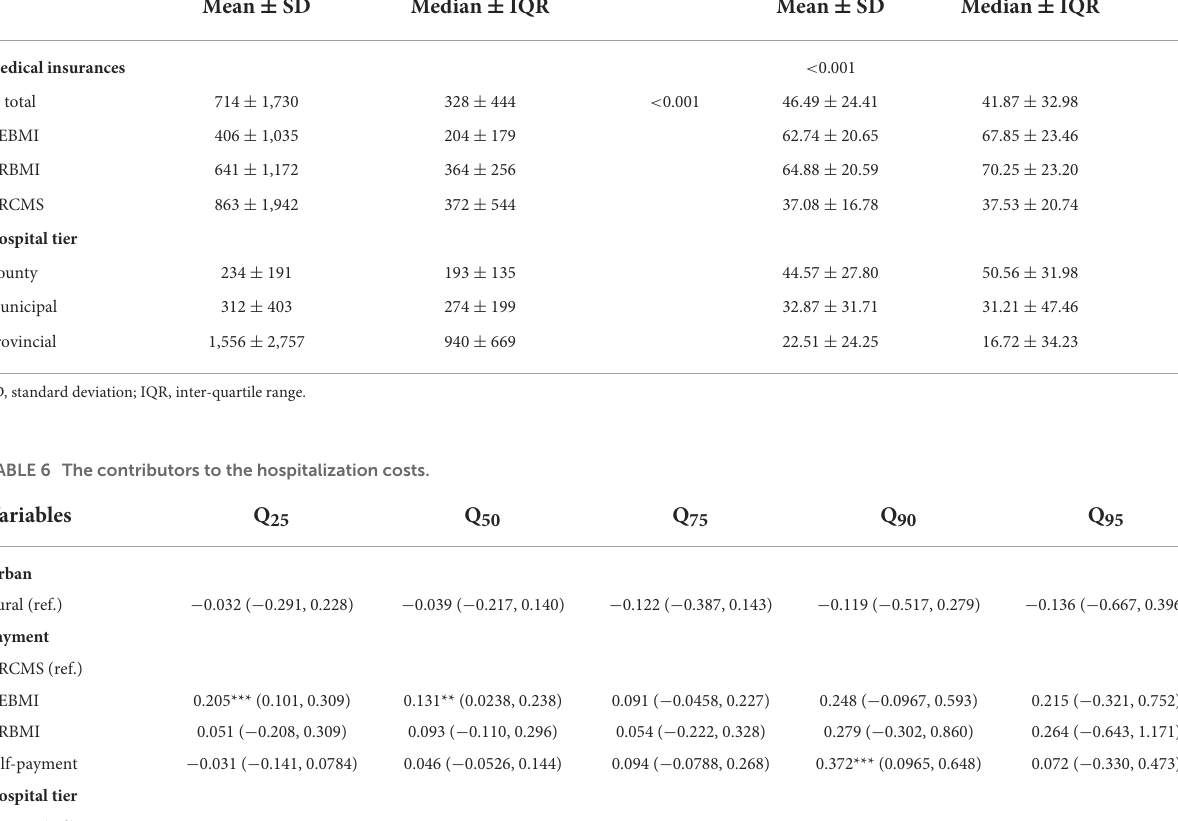
TABLE 5 The out-of-pocket payments and the reimbursement rates among malaria inpatients of different subgroups (USD). Characteristics